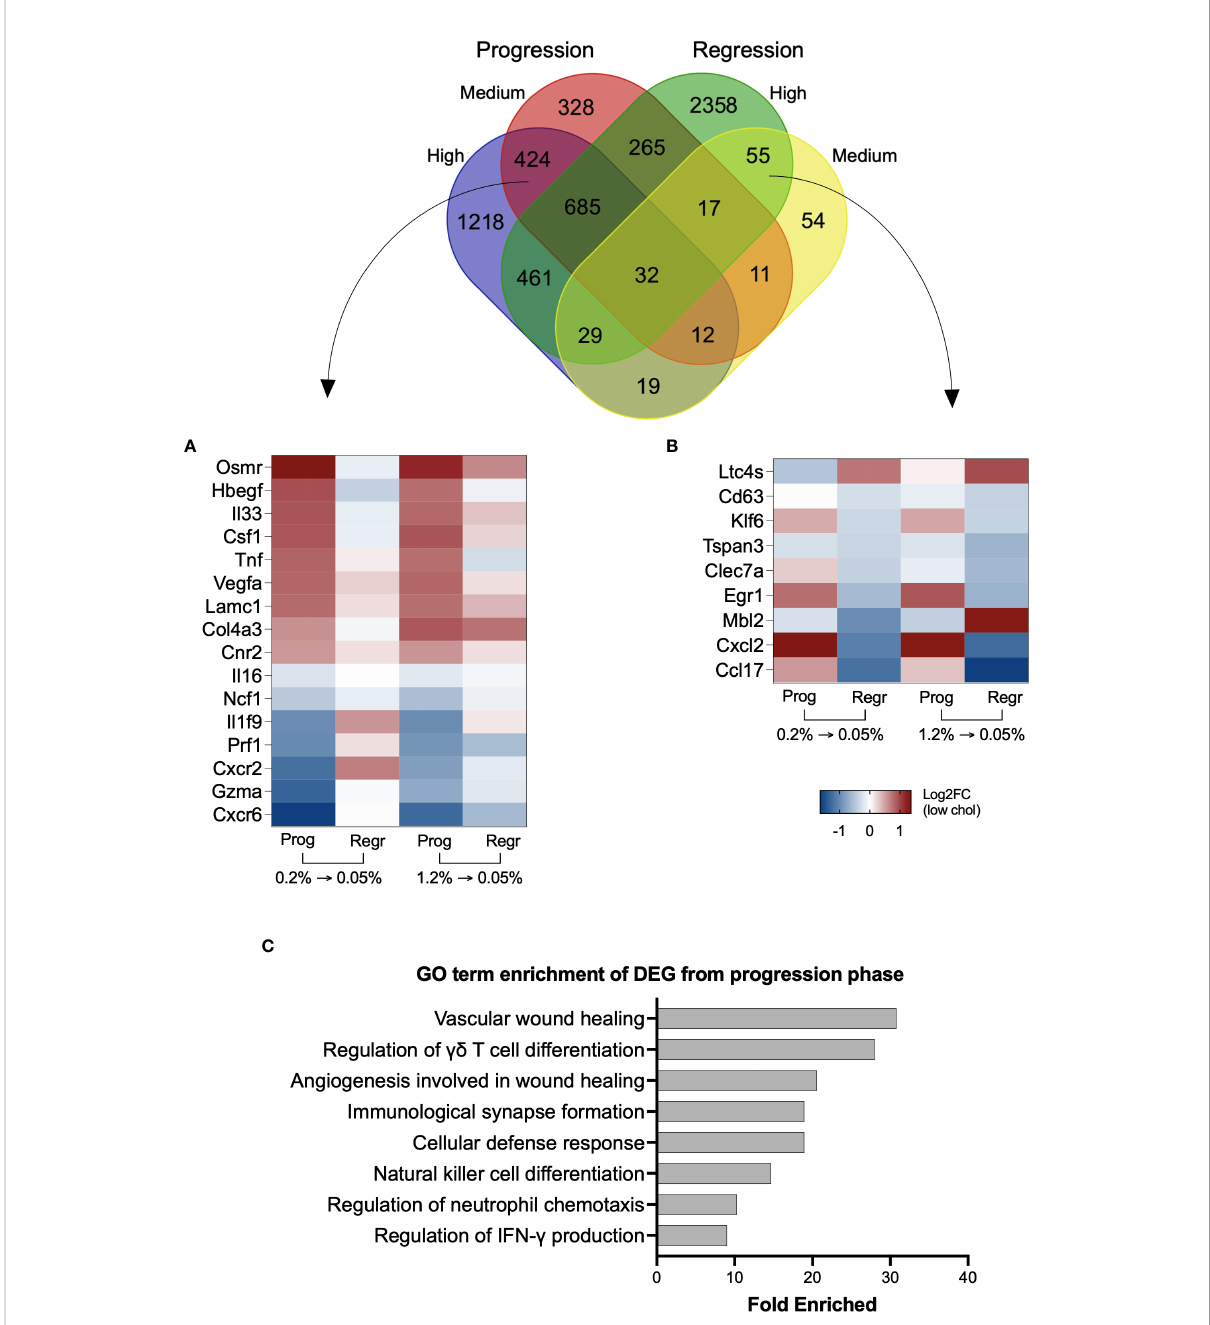
FIGURE 4 Genes uniquely modi fi ed by inclusion or reduction of dietary cholesterol can contribute to NASH. Venn diagram with the overlapping differentially expressed genes from the four groups. High and medium cholesterol groups commonly expressed 424 genes during the progression phase, while only 55 genes uniquely were commonly found during the regression phase. (A) Heatmap with 16 genes from the 424 genes upregulated by cholesterol introduction. The selected genes are previously correlated to NAFLD severity. Overall, these genes followed a similar expression pattern during the progression phase of medium and high cholesterol groups, with reversal of expression pattern on cholesterol reduction. (B) Heatmap showing 9 of the 55 genes commonly expressed in medium and high cholesterol groups after cholesterol reduction. The genes of interest are involved in NASH in fl ammation. (C) Gene Ontology (GO) terms enrichment using the differentially expressed genes (DEG) induced by cholesterol during the progression phase. Most of the biological functions were related to immune response. No signi fi cant results were found using the 55 genes commonly modi fi ed during the regression phase. Log2FC, log2-foldchange based on low cholesterol age-matched group. Prog, Progression phase; Regr, Regression